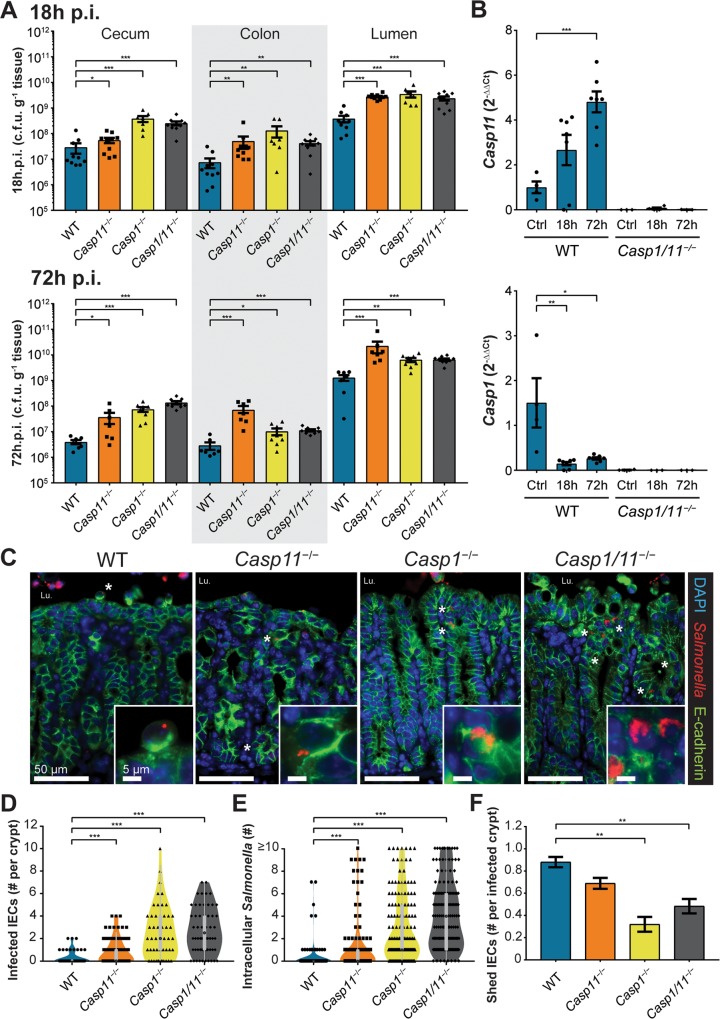
Inflammatory caspases are required for the epithelial restriction of a Salmonella infection in vivo.Streptomycin-pretreated C57BL/6 (WT), Casp11−/−, Casp1−/− and Casp1−/−/Casp11−/− (Casp1/11−/−) mice were orally infected with S. Typhimurium (3 × 106 c.f.u.), with intestinal tissue and luminal contents plated at 18 h post infection (p.i.) and 72 h p.i. (A). Casp11 and Casp1 gene expression enumerated relative to Rplp0 reference from cecal RNA of streptomycin pretreated controls, 18 h p.i. and 72 h p.i., WT and Casp1/11−/− mice. (B). Representative fluorescence images of infected cecal tissues at 18 h p.i. Salmonella O-antigen (red), E-cadherin (green), and DNA (blue) (C). Original magnification ×200, Inset ×630; scale bars 50 μm, inset scale bars 5 μm. Asterisk denotes presence of intracellular Salmonella (L.u. denotes cecal lumen). The number of Salmonella-infected IECs per a crypt (D), the number of intracellular Salmonella in each infected IEC (E) and the proportion of apically shedding IECs adjacent to infected crypts (F). Statistical significance for 1A and 1D-F calculated using Mann-Whitney U-test with student t-test applied to 1B (*p<0.05; **p<0.01; ***p<0.001). Each symbol represents one mouse. Mean and SEM are indicated. Results are from at least two independent experiments. Blinded 18 h p.i. cecal tissue analyzed in 1D-F were from n = 5 mice (with 50 representative crypts scored) from at least two independent experiments.